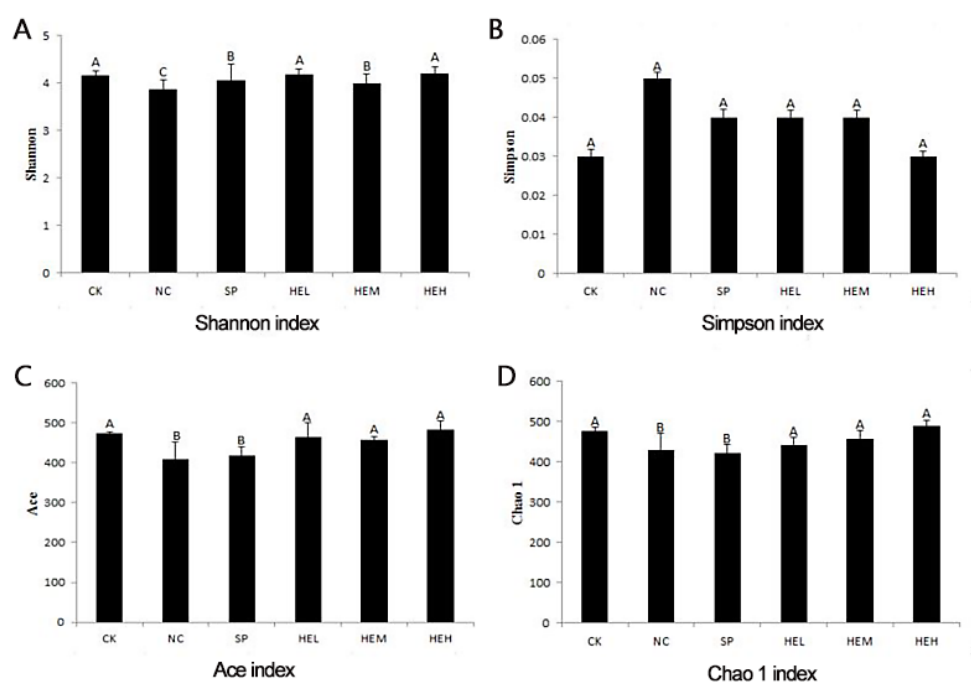
Figure 6. ( A ) Shannon index. ( B ) Simpson index. ( C ) Ace index. ( D ) Chao 1 index. Different letters indicate significant differences ( p < 0.05).